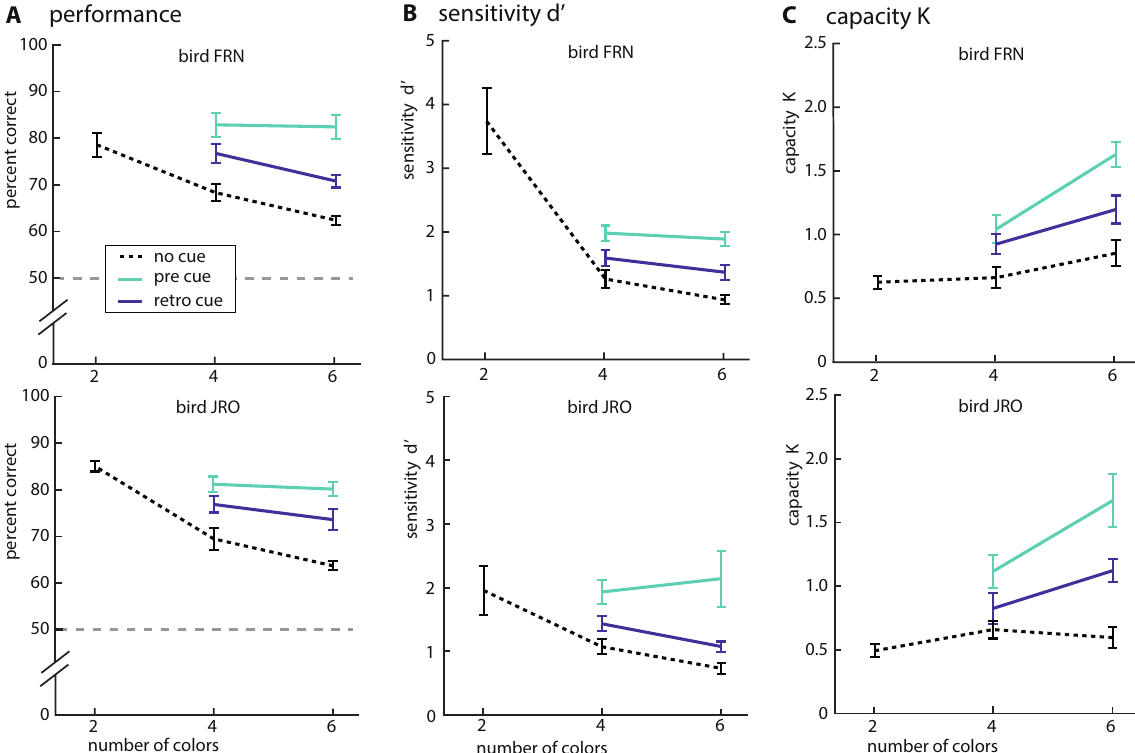
Figure 2. The effect of pre- and retro cues on performance. Both clues lead to an improvement in performance, visible in both animals and at all WM-loads. Error-bars indicate SEM, line style indicates the type of cue. ( A ) Behavioral performance (percent correct) of both crows (FRN, JRO) as a function of WM-load (2, 4, 6 colors) and cue-condition. Grey dashed line indicates chance-level. ( B ) Sensitivity (d’) of both crows as a function of WM-load and cue-condition. ( C ) Pashler’s K of both crows as a function of WM-load and